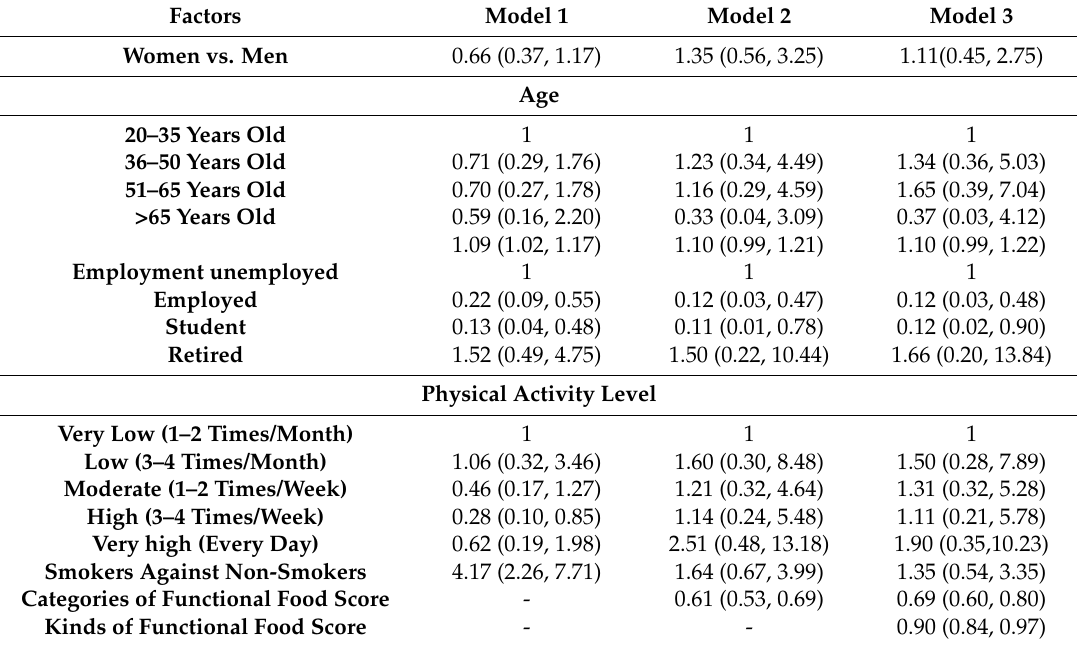
Table 4. Multifactorial analysis results to evaluate the relationship between the scores for functional food categories and for functional food kinds and the likelihood of gastrointestinal diseases, based on age, occupation, and physical